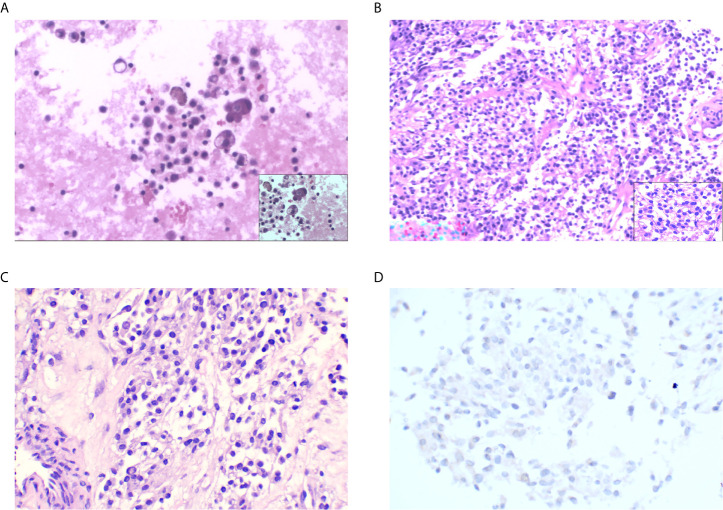

(A) Scattered lymphocytes, tissue cells, mesothelial cells, and individual atypical cells (H&E staining: original magnification ×100). (B) Epithelioid tumor cells distributed in nests and sheets around fibers and blood vessels; some of the cells have transparent cytoplasm with nuclear division (H&E staining: original magnification ×100). (C) PD-L1 control (H&E staining: original magnification ×100). (D) PD-L1-negative staining.